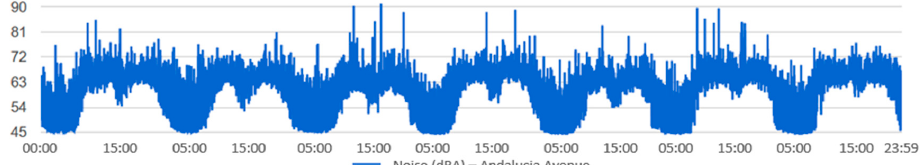
Figure 12. The temporal evolution of the noise from 00:00 to 23:59 on 30 June 2017 in San Francisco Square.